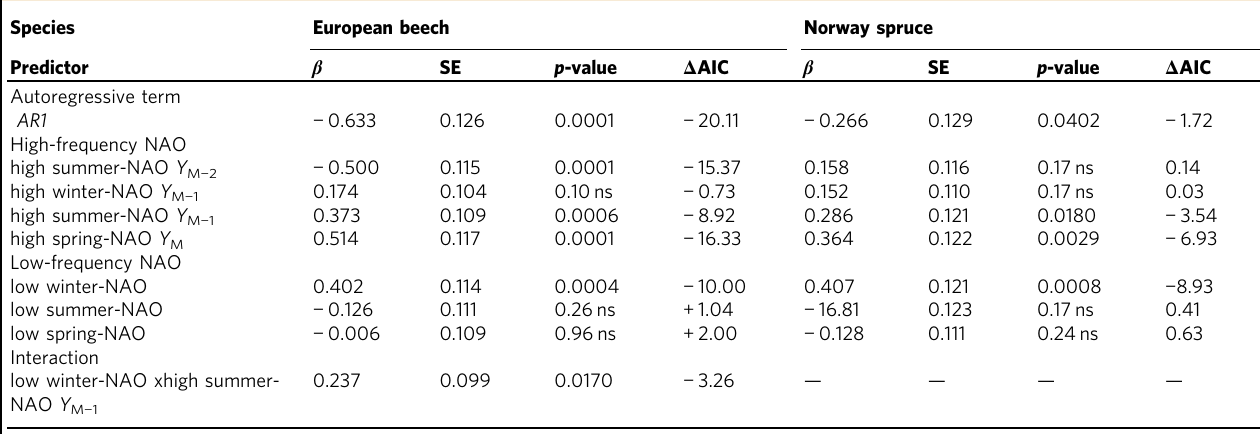
Table 2 Final regression model